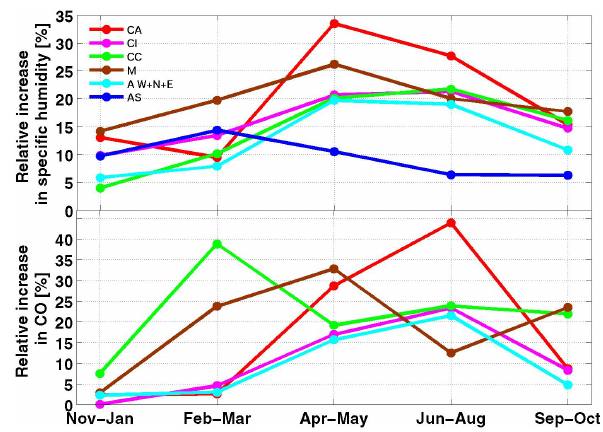
Fig. 12. Relative increase in the specific humidity and in CO con- centration calculated from JFJ and Payerne data for all weather types and for the defined periods of the year. Data for the AS weather type was taken from the Stabio site, south of the